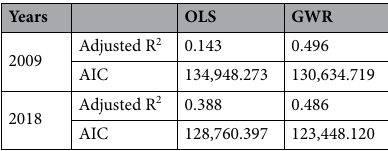
Table 6. Comparison of AIC values between OLS and GWR